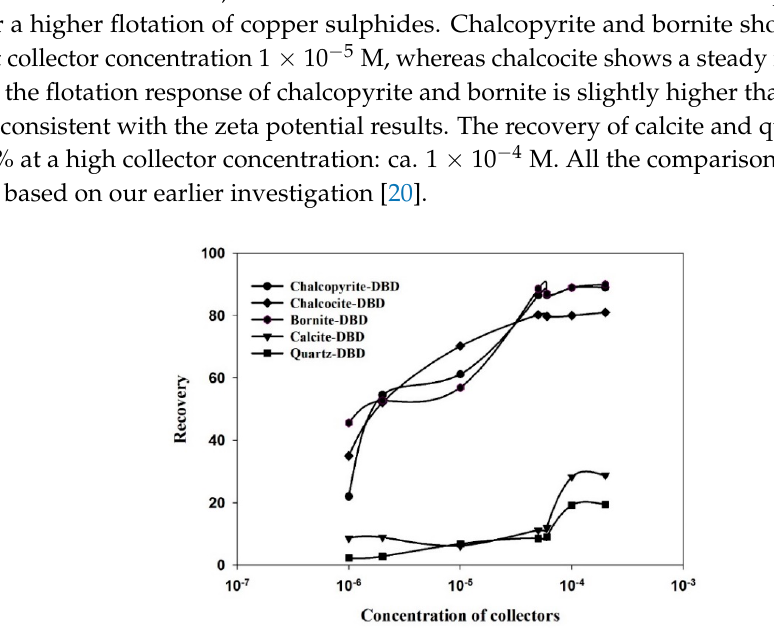
Figure 7. The Hallimond flotation recovery as a function of pH at collector concentration 5 × 10 − 5 M.